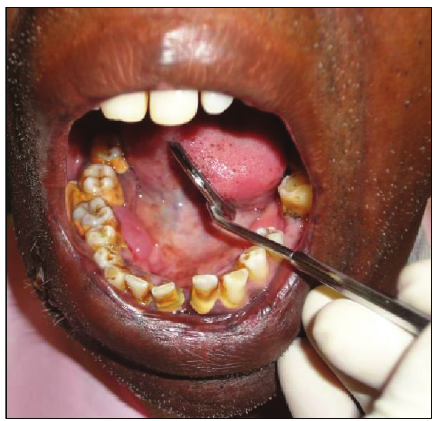
Figure 1: Clinical photograph of pre-op intraoral choristoma.